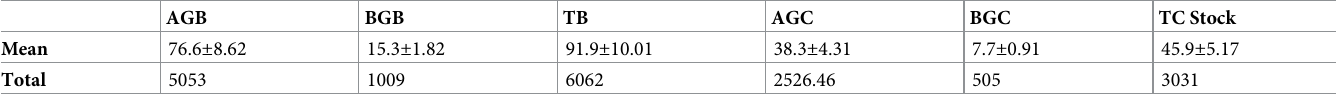
Table 3. Summary of total and mean values of biomass and C stock (Mg ha − 1 ) in above- and belowground compartments in Kibate Forest. AGB BGB TB AGC BGC Mean 76.6 ± 8.62 15.3 ± 1.82 Total 5053 1009